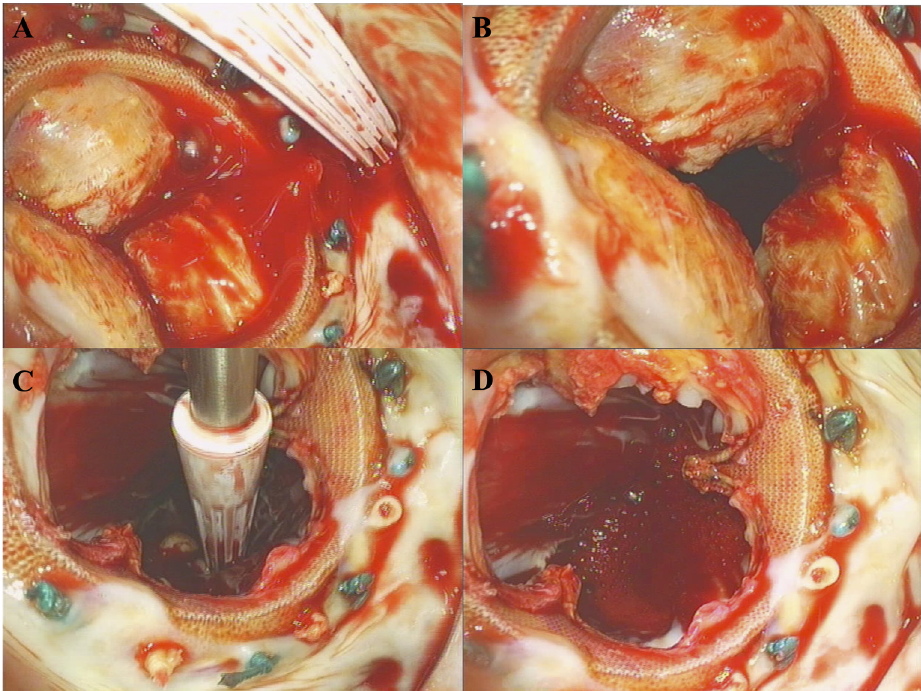
Fig. 1 - Deteriorated mitral valve prosthesis in situ. A) calcified mitral valve prosthesis; B) coaptation defect; C-D) excised leaflets of the deteriorated mitral valve